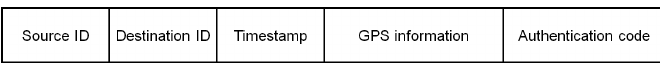
Figure 5. Message structure for